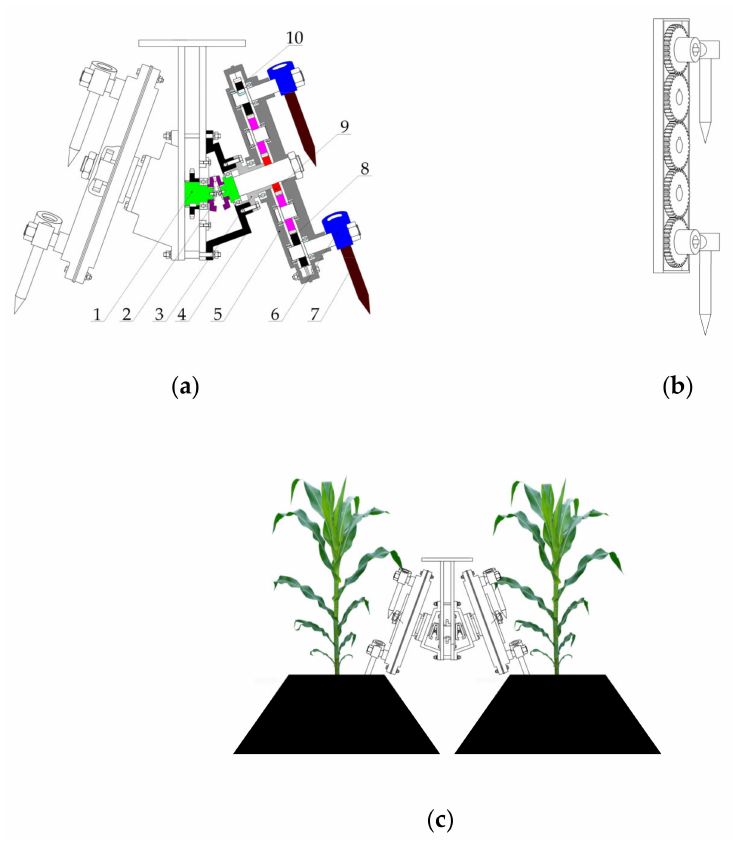
Figure 3. Drilling mechanism. ( a ) two-dimensional diagram of the structure. ( b ) two-dimensional diagram of spur gear planetary systems. ( c ) diagram of field work. 1. sprocket shaft; 2. helical gear; 3. Flange; 4. outer casing; 5. planetary frame; 6. rocker arm; 7. fertilizer spray needle; 8. upper planetary wheel; 9. intermediate wheel; 10. lower planetary